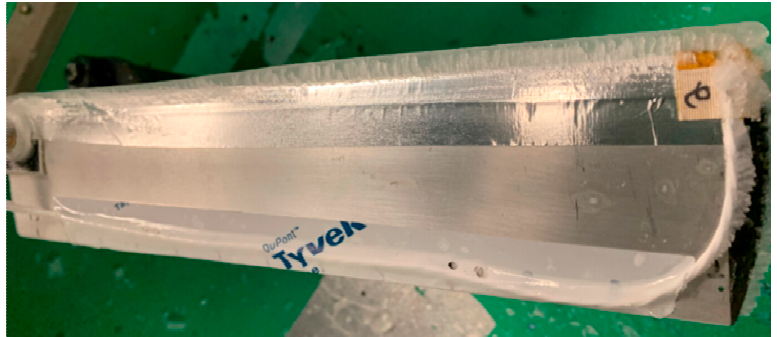
Figure 13. Glaze ice accumulation on aluminum during de-icing tests at − 7.5 °C. Testing is repeated three times for each substrate and the average power density obtained for all the different substrates is presented in Figure 14. The total power consump- tion for the aluminum is 95.1 ± 2.0 W with a power density of 4.0 ± 0.1 W/in 2 , while it is 104.3 ± 8.2 W with a power density of 4.3 ± 0.3 W/in 2 for Coating 1, 93.3 ± 9.6 W with a power density of 3.9 ± 0.4 W/in 2 for Coating 2, 92.4 ± 11.6 W with a power density of 3.9 ± 0.5 W/in 2 for Coating 3 and 113.9 ± 12.8 W with a power density of 4.7 ± 0.5 W/in